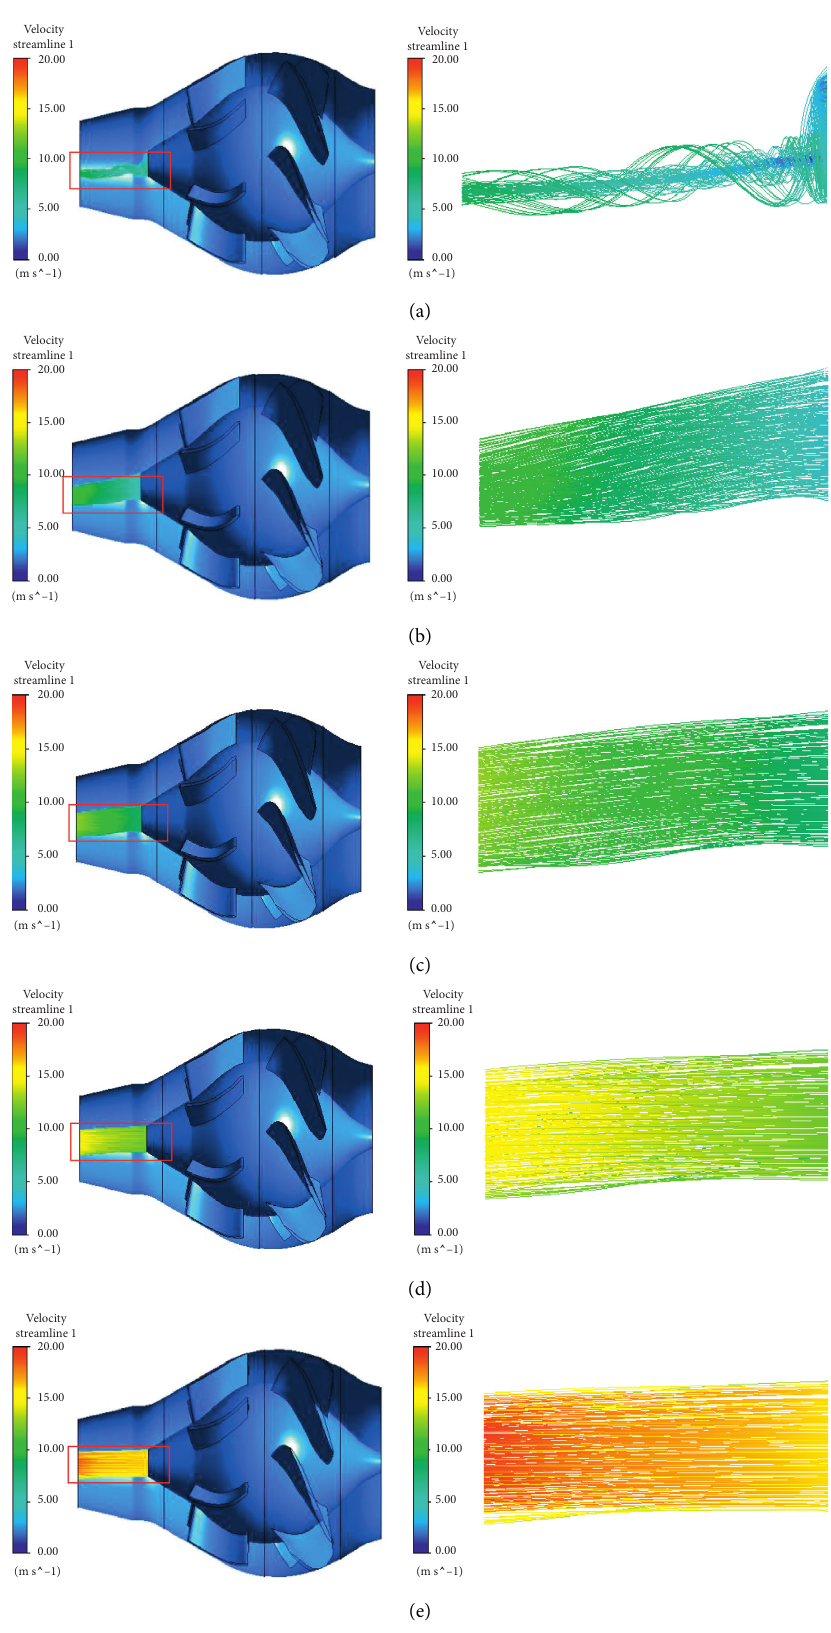
Figure 11: Streamline diagram in front of the outlet of the jet tube at different jet velocities: (a) v � 16 (m s − 1 (e) v jet